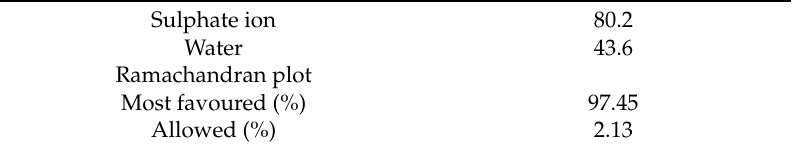
Table 4. Structure solution and refinement. Values for the outer shell are given in parentheses.